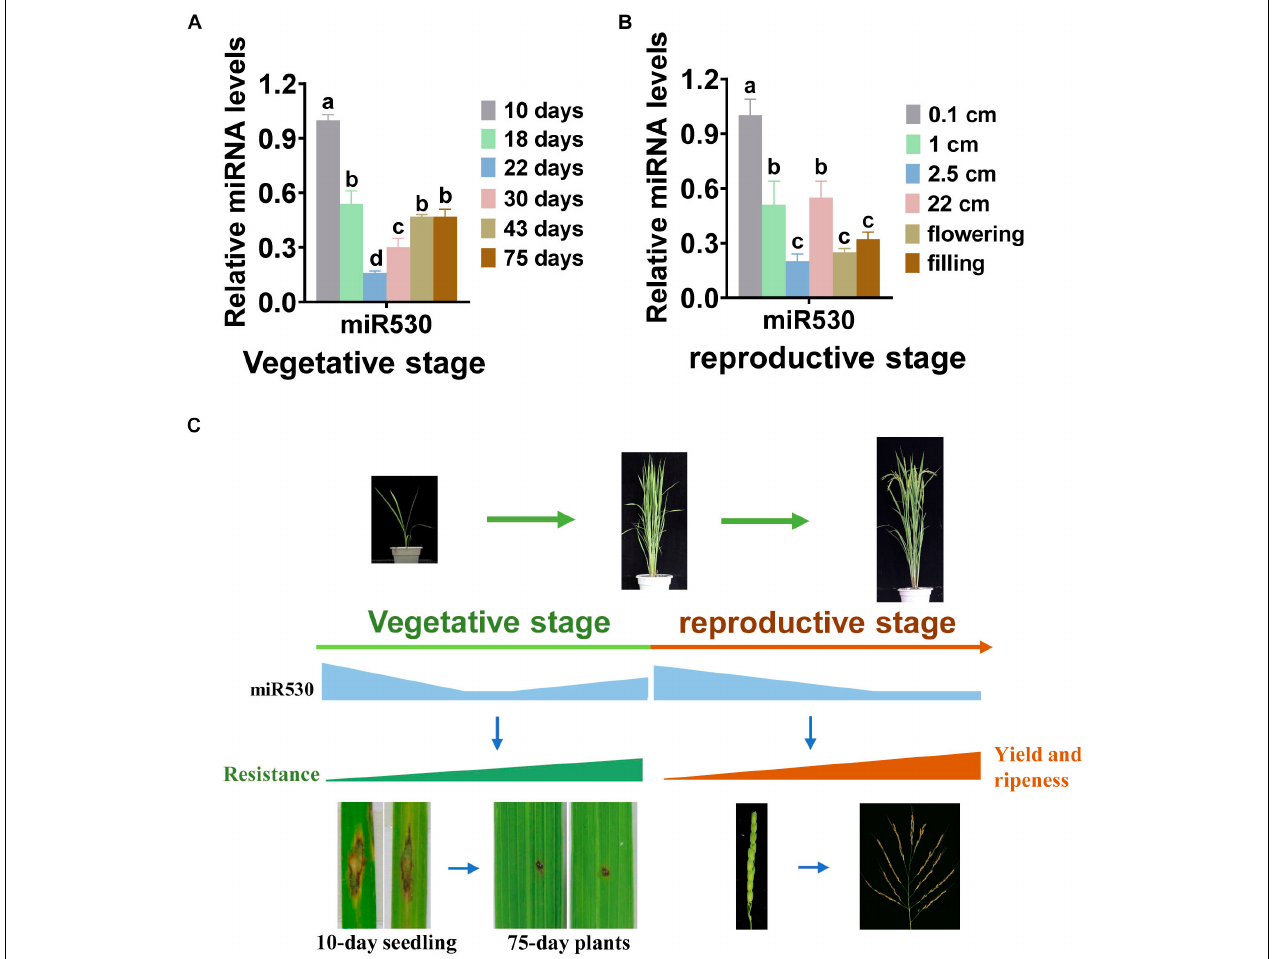
FIGURE 6 | miR530 dynamically expressed during the whole growth period in rice. (A) The accumulation of miR530 in rice leaves during the vegetative stage. (B) The accumulation of miR530 in rice panicles during the reproductive stage. For (A,B) , the data are shown as mean ± SD ( n = 3 independent samples). The mRNA levels were normalized to that in the indicated control. Different letters above the bars indicate significant differences ( P < 0.01) as determined by the one-way ANOVA analysis. (C) A model shows the relationship among the amount of miR530, resistance, yield, and growth period throughout the growth period. During the whole growth period, miR530 is gradually decreased to coordinate disease resistance, maturity, and panicle development. The photograph shows the disease symptom that was captured from 10-day seedlings and 75-day plants inoculated with GZ8.